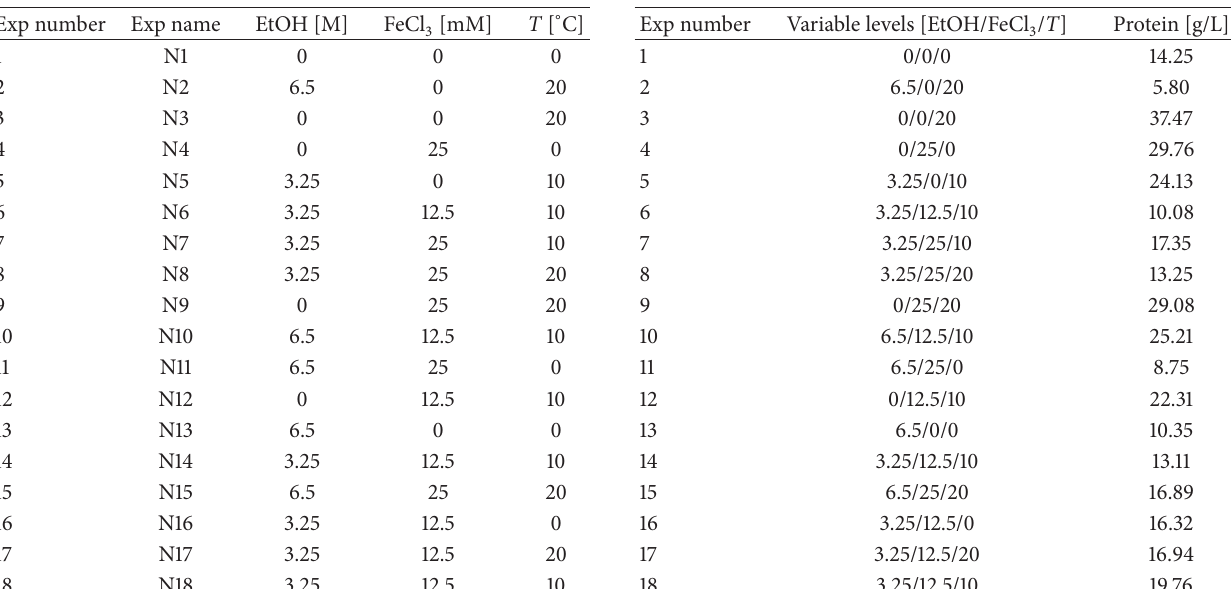
Table 1: Experiment matrix for RSM. Table 2: Resoluble protein concentration in precipitates.